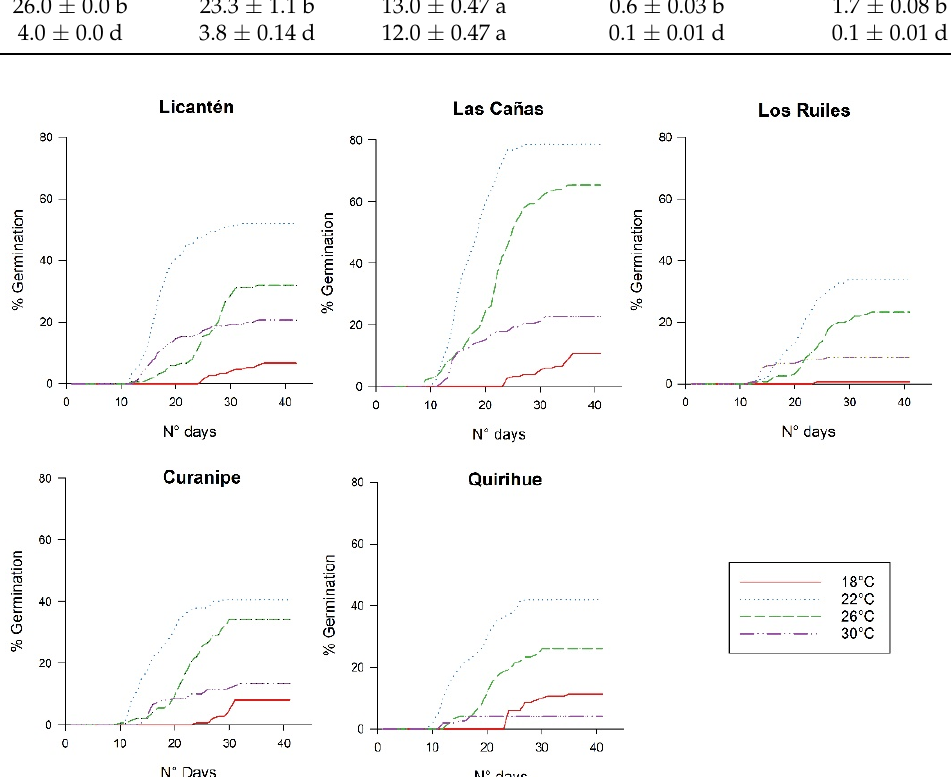
Figure 1. Cumulative germination percentage during 40 days for five Nothofagus glauca provenances treated at different temperatures in the absence of light.